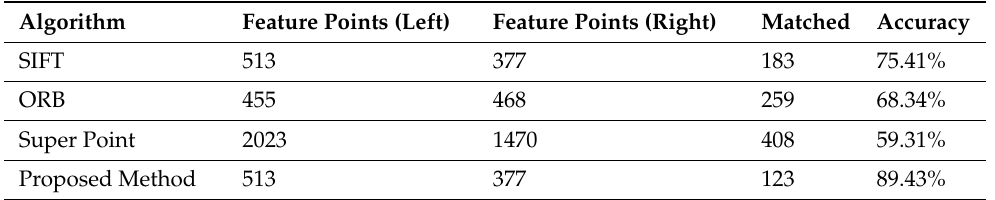
Table 1. Comparison of experimental results for Figure